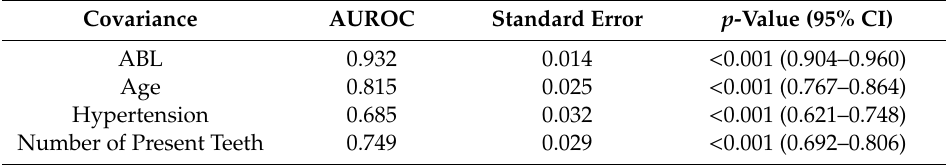
Table 4. E ff ective factors for the screening of carotid artery calcification using ROC